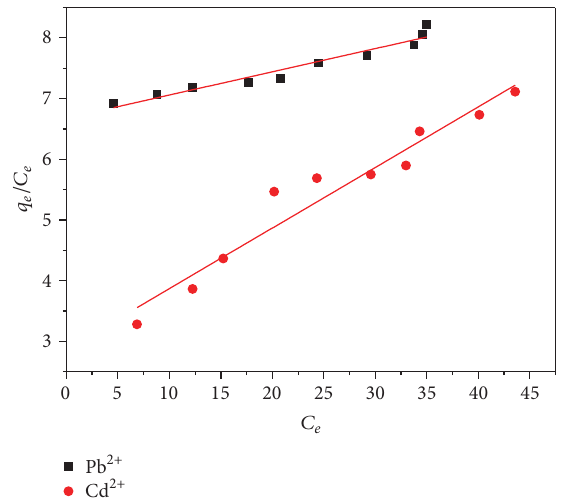
Figure 12: Langmuir isotherm curve fitting of Pb 2+ and Cd 2+ adsorption for cross-linked starch